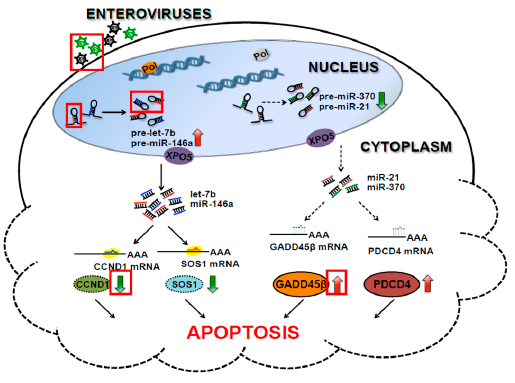
Figure 1. Cellular miRNAs are involved in Enterovirus infection-induced apoptosis. Hexagons indicate Enterovirus, hairpins indicate pre-miRNAs, red arrows indicate upregulated expression and green arrows indicate downregulated expression.